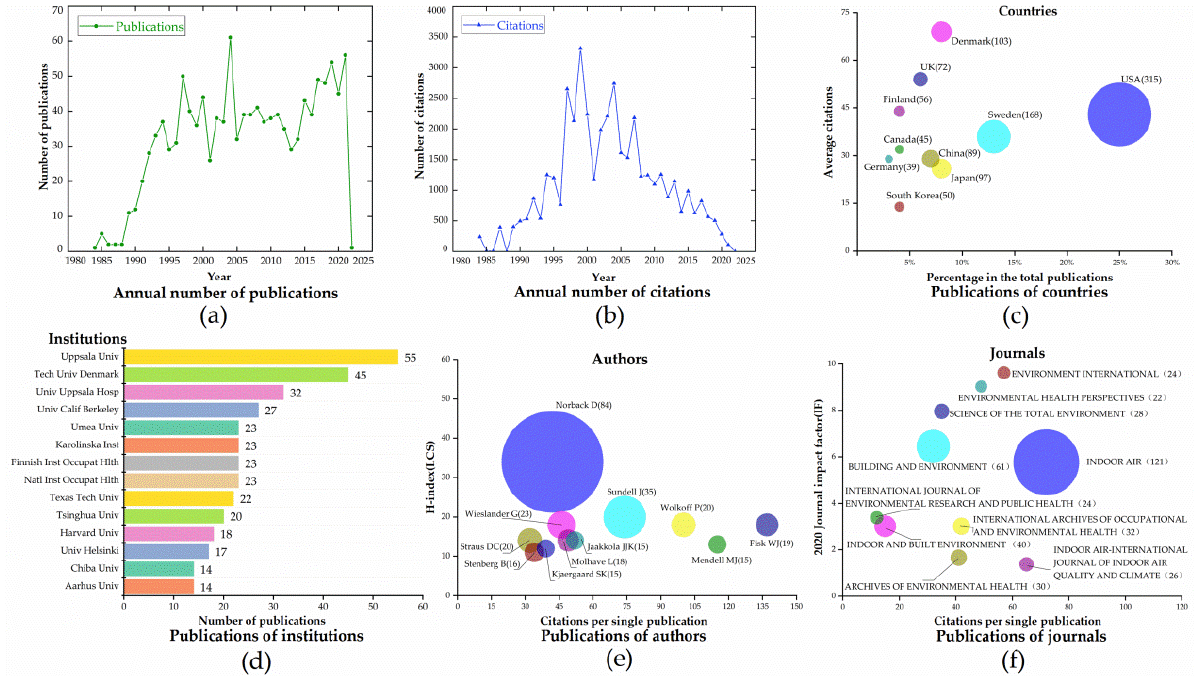
Figure 3. Basic bibliometric analysis of the SBS. (Note that the size of the nodes in ( c , e , f ) represents the difference in publication numbers. When the area of the nodes is larger, the publication number of the node is greater).